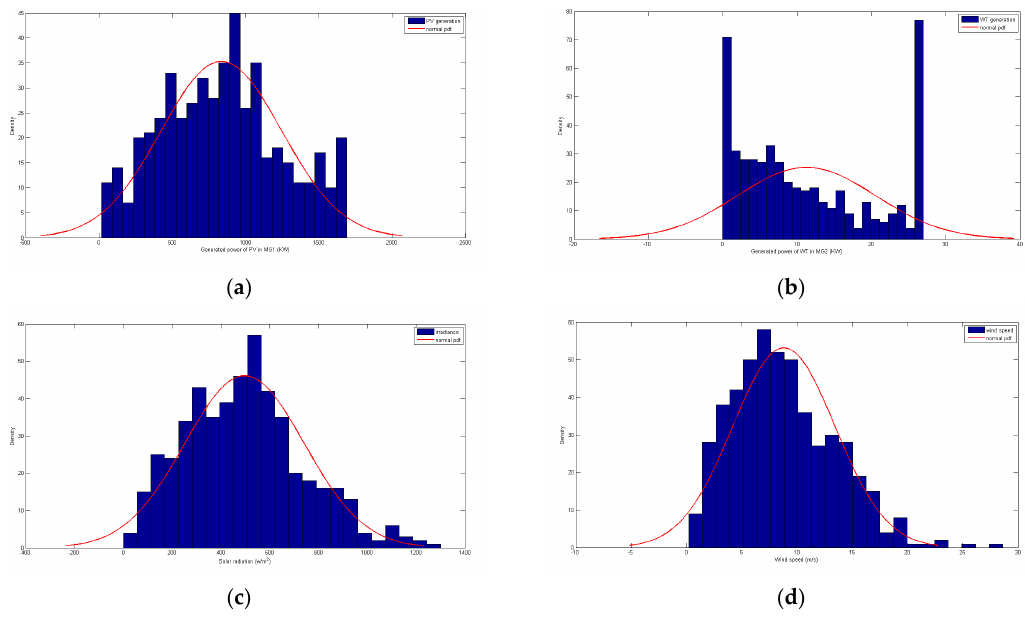
Figure 5. Probabilistic modeling of the PV and WT primary input and generated electricity in MCNMG: ( a ) PV, ( b ) WT, ( c ) solar radiation, ( d ) wind speed Table 2. Values of parameters in WT and